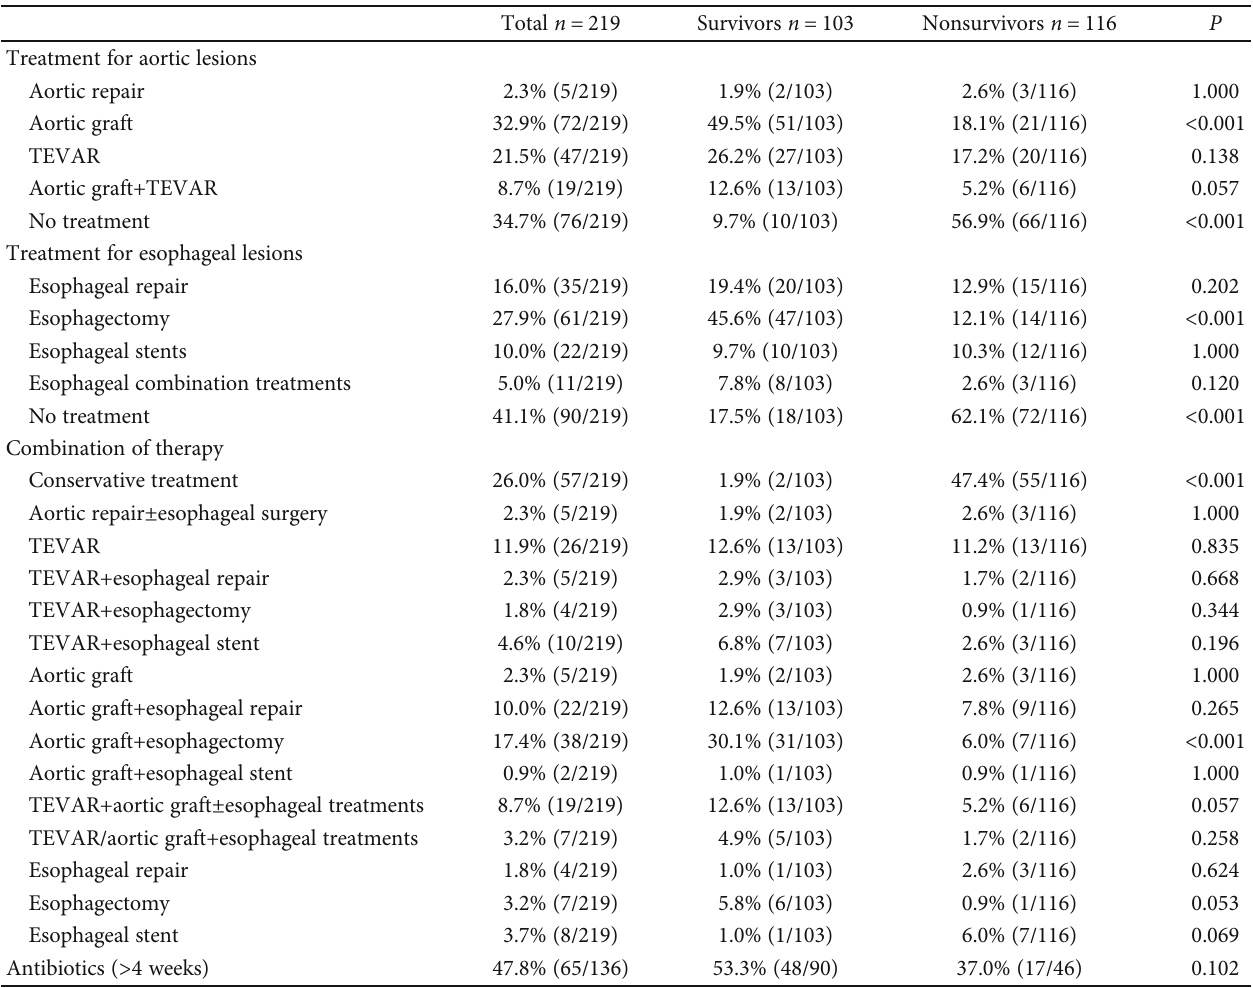
Table 3: Treatments and outcomes of patients with AEF.